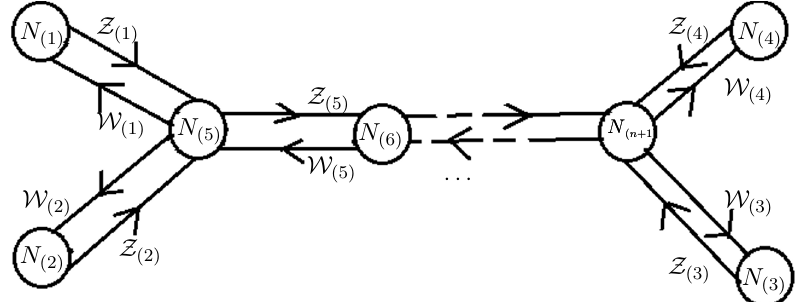
Figure 2 . b D n quiver